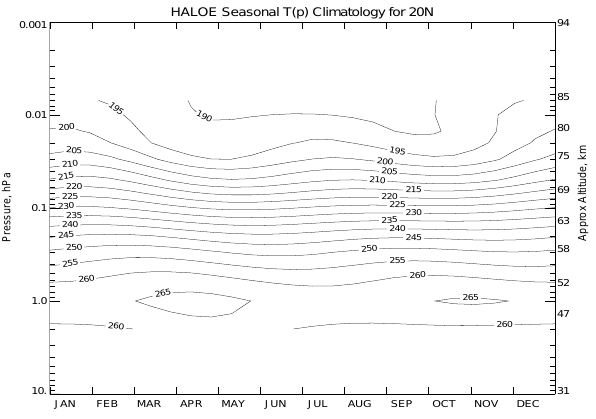
Fig. 6. Seasonal variation of the HALOE T (p) climatology for 20N. Contour interval is 5K.